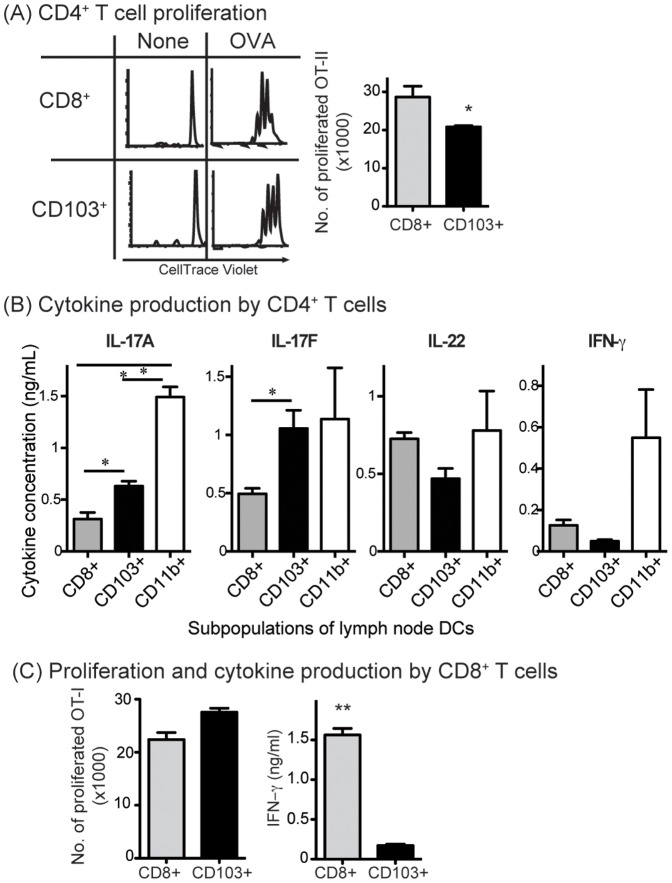
CD103+ DCs and CD8+ DCs induce naïve T cells to produce different cytokines.DC subsets from peripheral LNs of B6 mice were sorted. (A&B) DCs (104/well in triplicate) were cultured with CellTrace violet-labeled OT-II cells (5×104/well) with or without 1 mg/mL OVA for 3 d. Cell proliferation and supernatant cytokine levels were determined. (A) CD4+ T cell proliferation; (B) Cytokine production. Histograms show proliferation profile of OT-II, Bar graph shows mean ± SEM (*P<0.05, **P<0.01; Two tail Student's T test). (C) DCs (104/well in triplicate) were cultured with CellTrace violet-labeled OT-I cells (5×104/well) with or without 0.1 mg/mL OVA for 3 d. Cell proliferation and supernatant cytokine levels were determined. Bar graph shows mean ± SEM (**P<0.01; Two tail Student's T test).